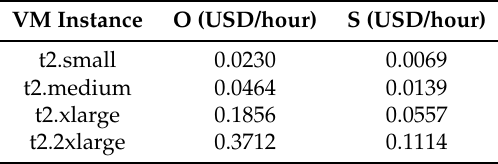
Table 1. On-demand (O) and spot instance (S) characterization price per hour.